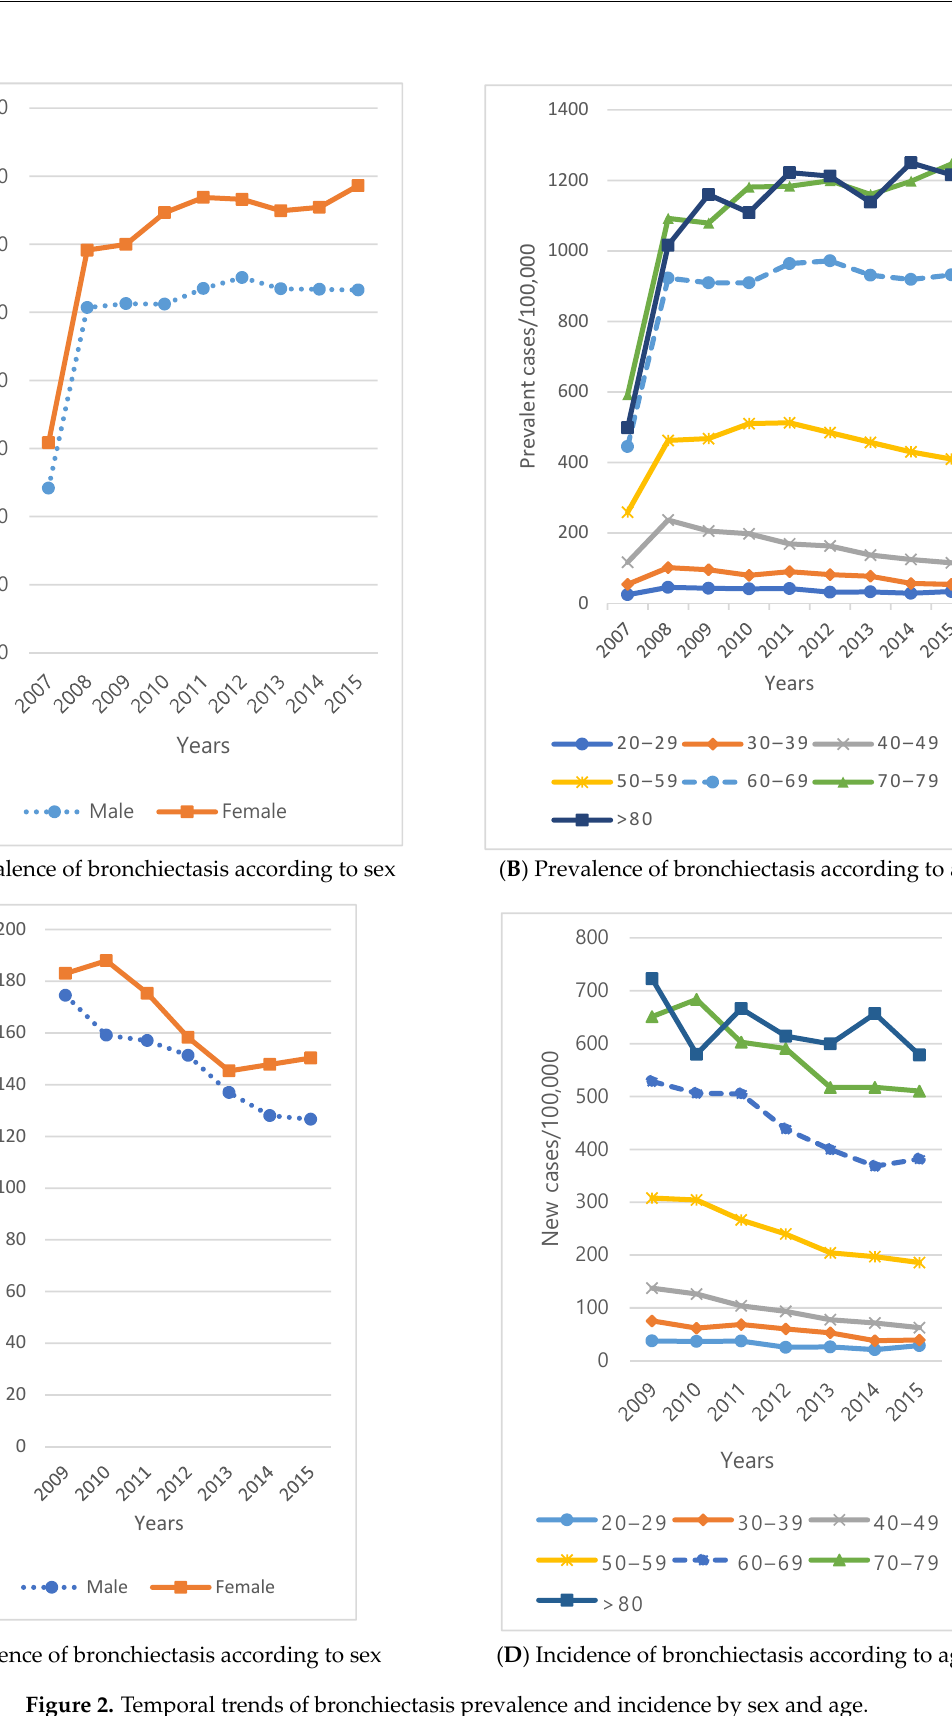
The prevalence of NTM increased from 4.1 to 57.8 per 100,000 males and from 5.1 to 88.6 for females (Figure 3A). The incidence rate increased from 12.5 to 33.9 in males from 2009 to 2015 and increased from 10.4 to 51.1 in females (Figure 3C). The incidence rate was higher in males, but the incidence rate in females showed a gradual increasing pattern (Figure 3C).